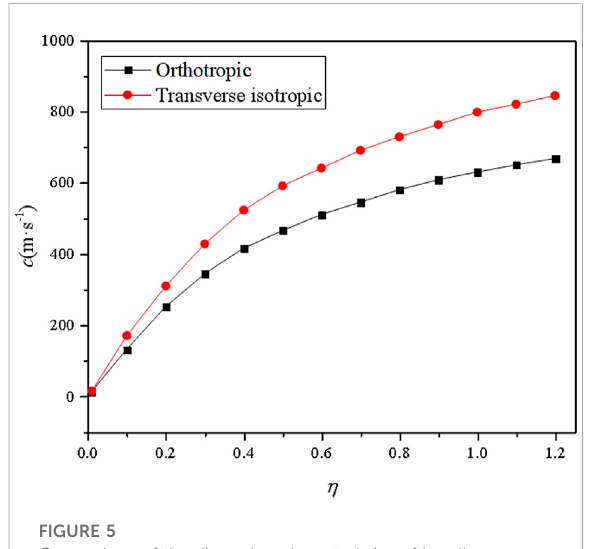
FIGURE 5 Comparison of the dispersion characteristics of bending edge waves in mm 2 piezoelectric plate and 6 mm piezoelectric plate under